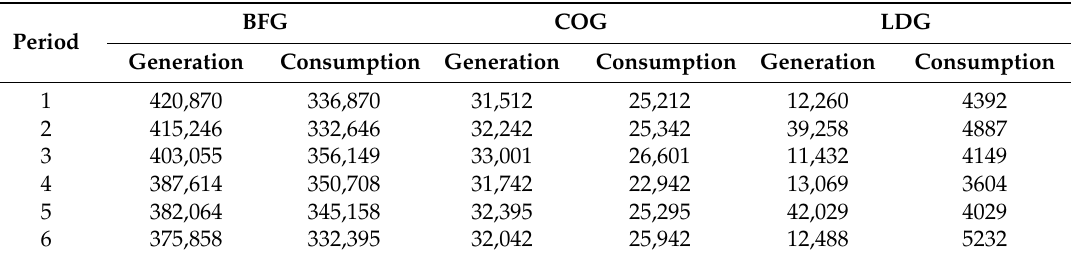
Table 4. Gas generation and consumption volumes (m 3 ) in each period.